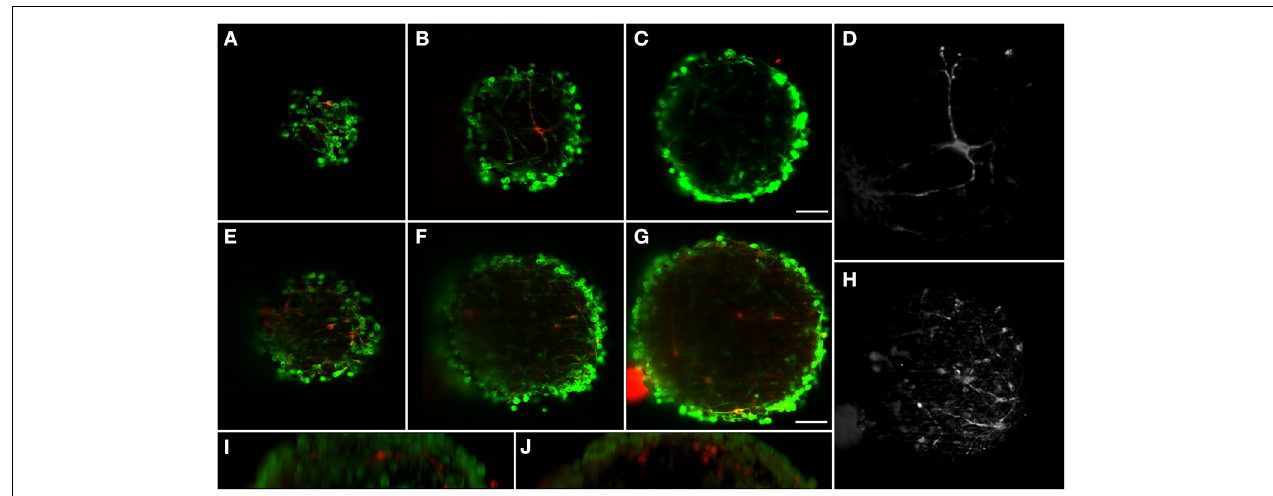
FIGURE 3 | Dopaminergic neurons distribution in two different differentiated neural aggregates with depth. BIII-tubulin was used as neuronal marker (green) and TH as dopaminergic marker (red). Neural aggregate #1 showing mature dopaminergic neurons with long axonal connections at: (A) 17 μ m from surface; (B) 43 μ m; and (C) 75 μ m. (D) Maximum intensity projection of the dopaminergic neuron.